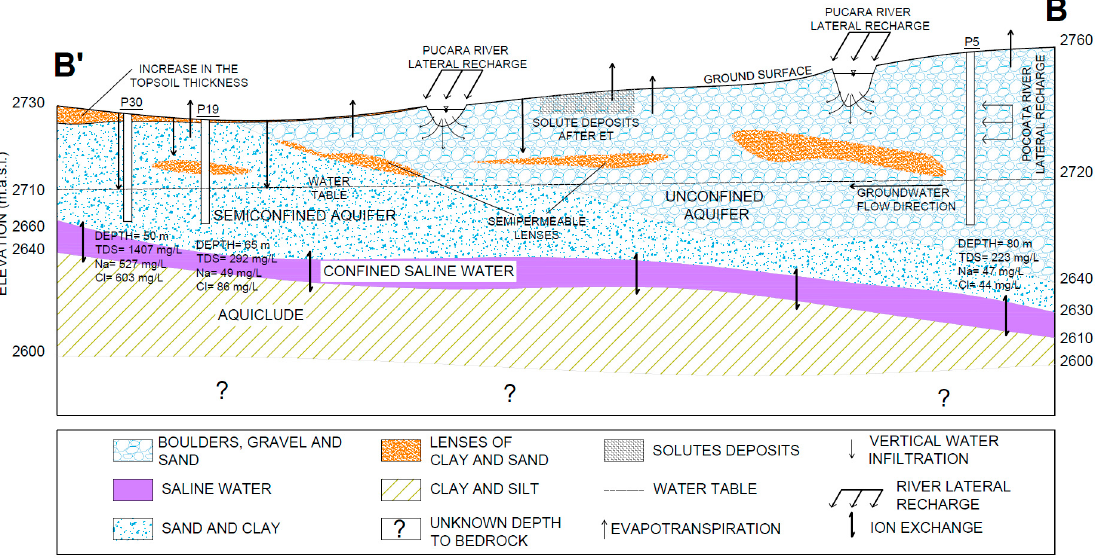
Figure 8. Hydrogeological conceptual model of the groundwater recharge and salinization processes along the section B-B’ (refer to Figure 1a for location and position of wells).